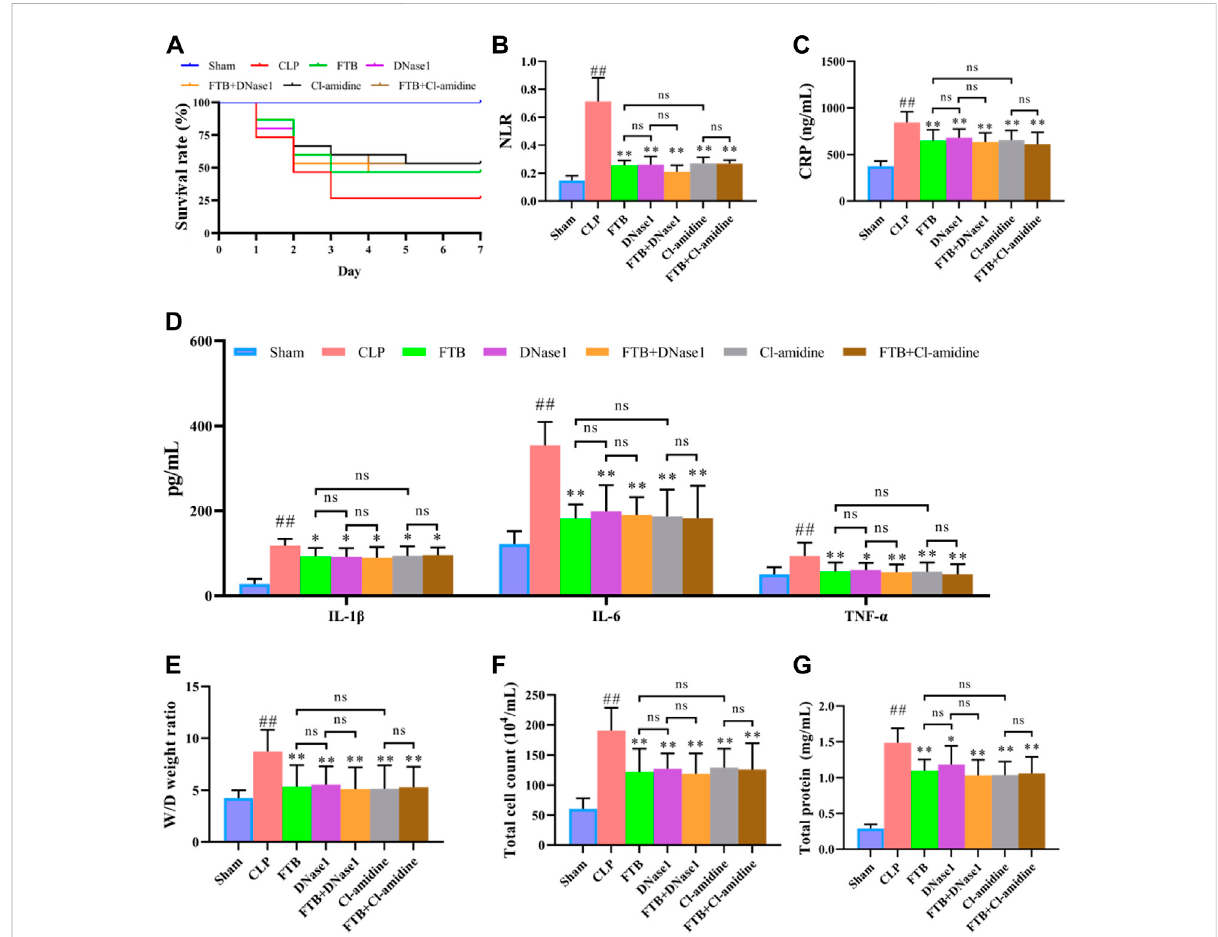
FIGURE 6 Effects of FTB treatment on survival rate, in fl ammatory response and lung permeability in rats with sepsis after inhibiting the formation of NET and the activity of PAD4. In rats with sepsis, treatment with FTB, DNase1 (NETs inhibitor) and Cl-amidine (PAD4 inhibitor) increased the survival rate (A) , reduced in fl ammation-related factors [NLR (B) , CLP (C) and pro-in fl ammatory cytokines (D) ] and decreased lung permeability [W/D ratio oflung tissue (E) , total cell count (F) and total protein concentration (G) in BALF]. However, no differences were observed in the survival rate, in fl ammation-related factors and degree of lung permeability between the FTB and DNase1 groups, FTB and Cl-amidine groups, DNase1 and FTB + DNase1groups,andCl-amidineandFTB+Cl-amidinegroups.Shamgroup( n =15),CLPgroup( n =8),FTBgroup( n =10),DNase1group( n =9),FTB + DNase1 group ( n = 10), Cl-amidine group ( n = 10), FTB + Cl-amidine group ( n = 10); ns: not statistically signi fi cant.